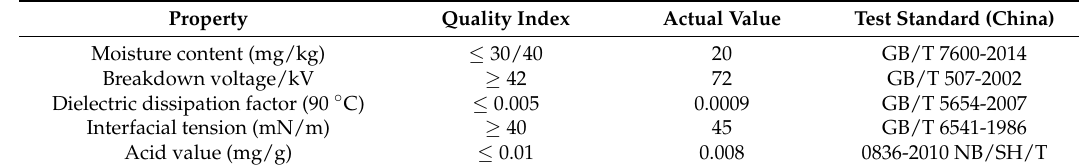
Table 2. Main properties of the filtered mineral